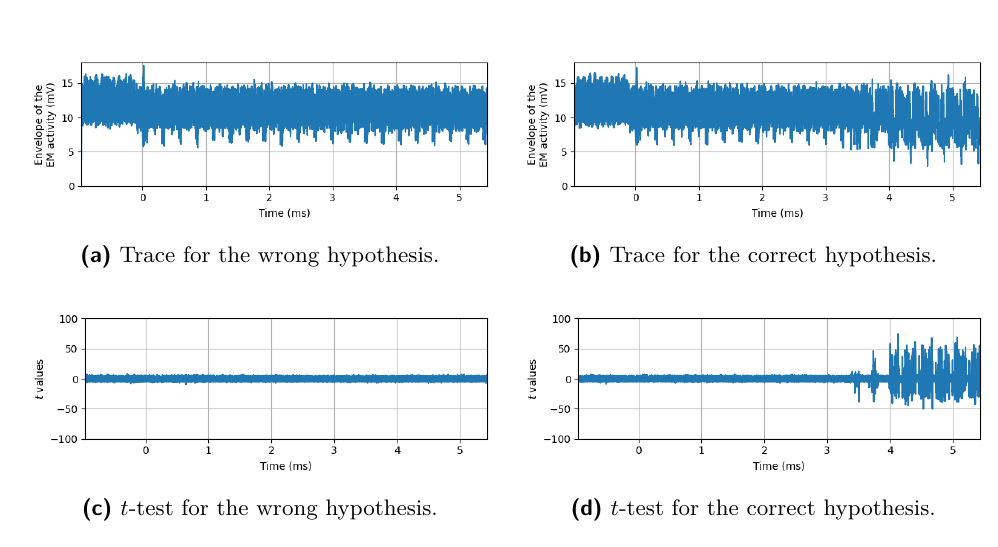
Figure 2: Experimental results for an attack on one